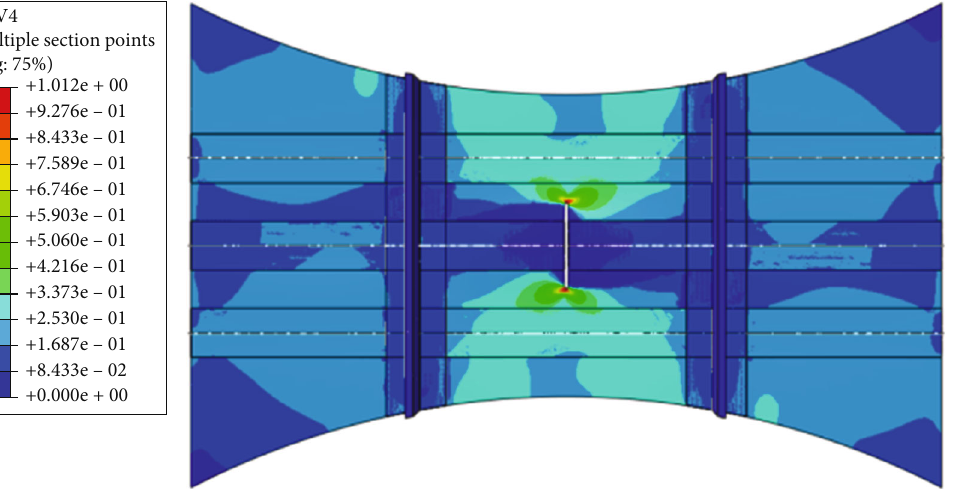
Figure 11: Fiber tensile damage initiation in the UMAT analysis.